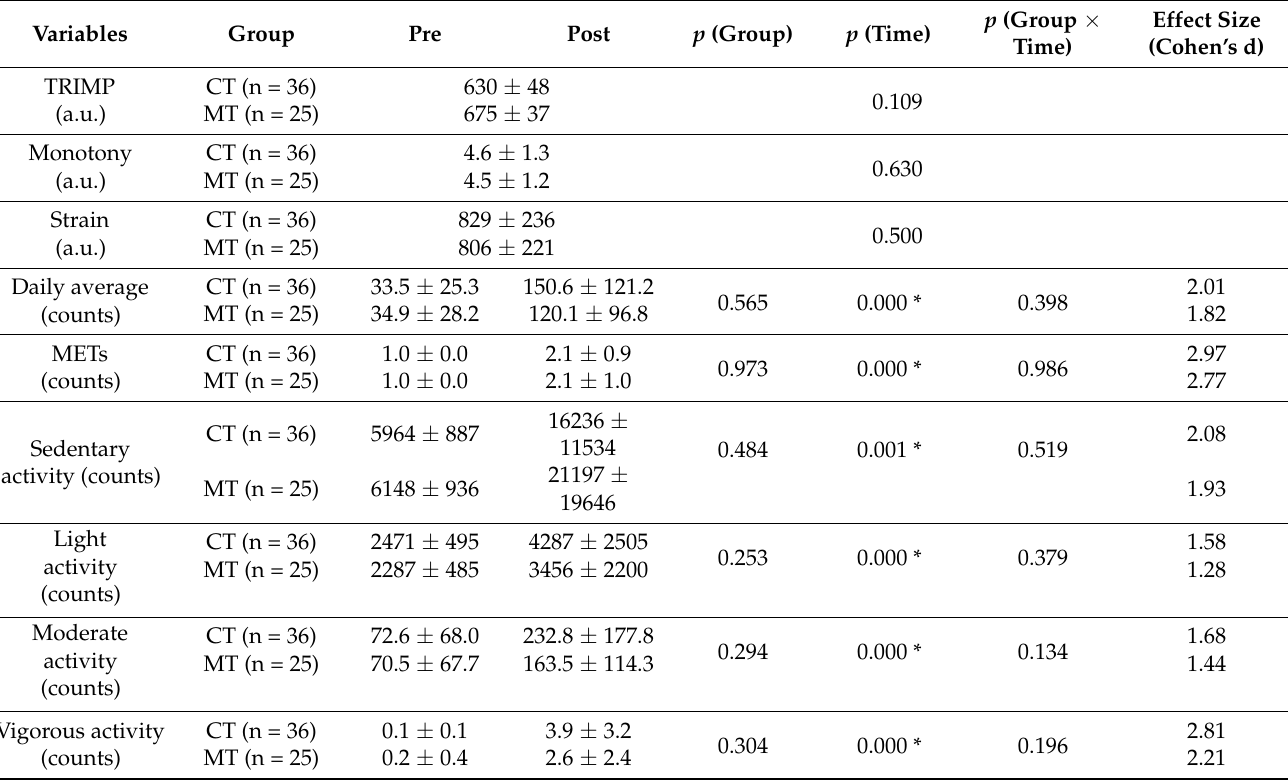
Table 4. Mean ± standard deviation of the values of training intensities and physical activity level pre- and post- intervention.